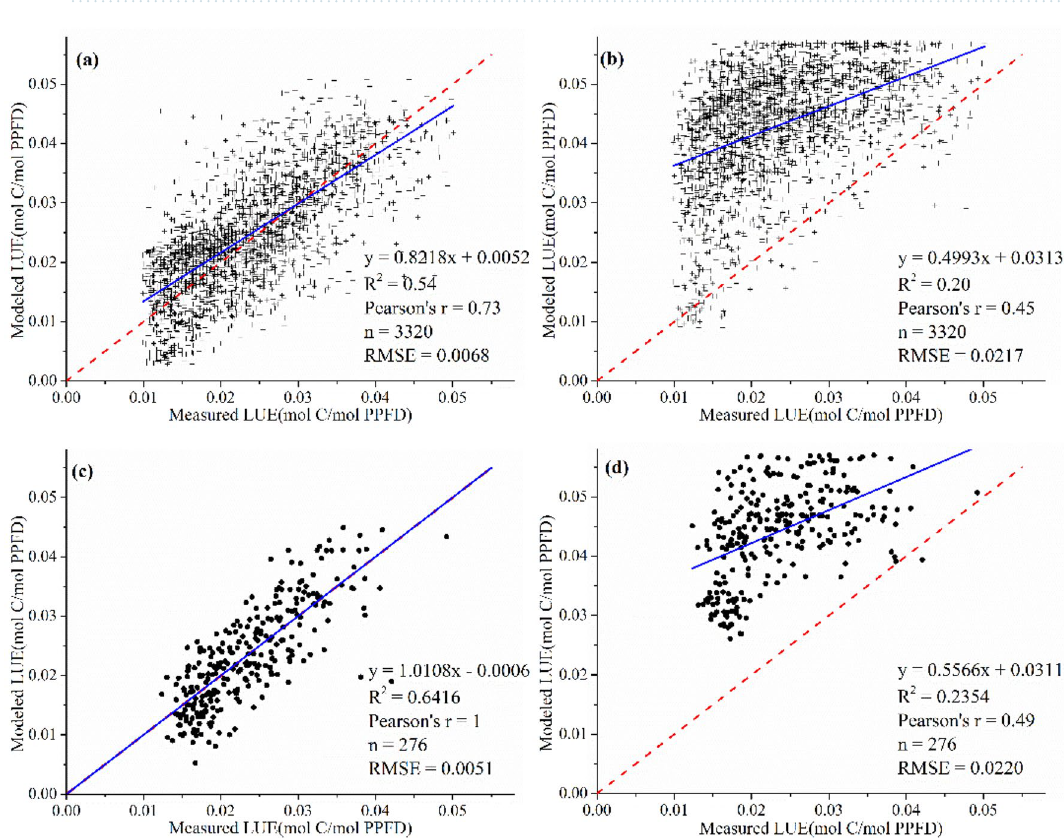
Figure 3. Validation of LUE estimated from terrestrial ( b , d ) and mangrove model ( a , c ) with daily- ( c , d ) and hourly-scale ( a , b )